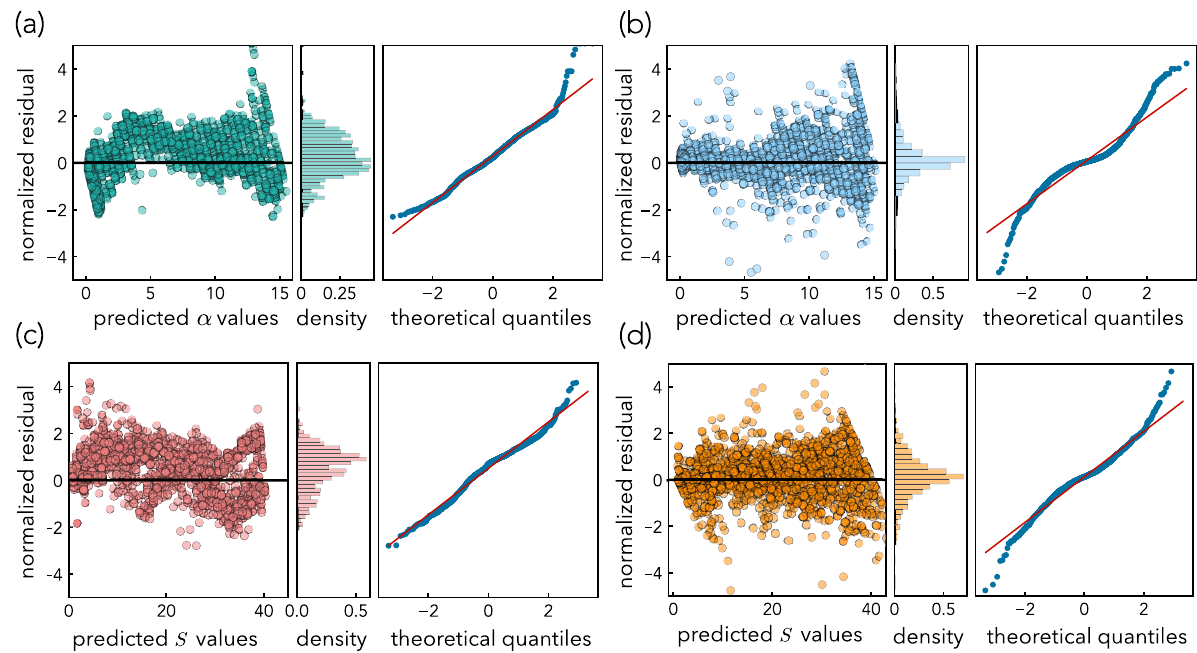
Figure 3. Residual analysis of the proposed models, showing the normalized residual plots, their densities, and the corresponding Q–Q plots. ( a ) α residuals from the L w -model as given by Eq. (3). Results show that L w -model underpredicts by ∼ 3% for 3 < α < 12 and overpredicts by 5.0% otherwise. The mean of the residuals is greater than zero, i.e., overall the model underpredicted α . The corresponding Q–Q plot suggests a near symmetric Gaussian distribution of residuals with a slight right-skew. ( b ) α residuals from the L M -model shows the residuals are more centered around zero with larger values than the L w -model. The corresponding Q–Q plot indicates a near symmetric Gaussian distribution of residuals with heavy tails. ( c ) S residuals from the L w -model shows an overall underprediction. The associated Q–Q plot shows Gaussian distribution of residuals with a slight right-skew. ( d ) Shows the residuals of S from the L M -model are centered around zero. The corresponding Q–Q plot suggests a near symmetric Gaussian distribution of residuals with heavy